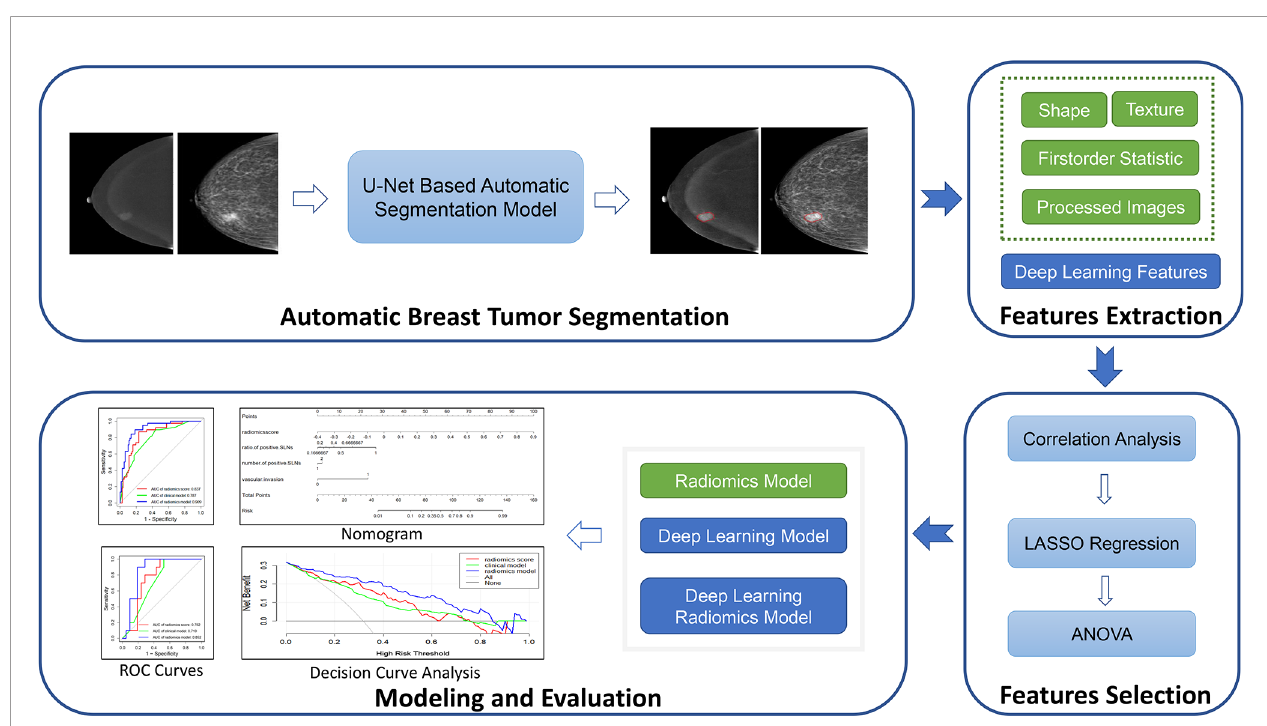
FIGURE 2 | Overview of the construction of the prediction models. LASSO, least absolute shrinkage and selection operator; ANOVA, analysis of variance; ROC, receiver operating